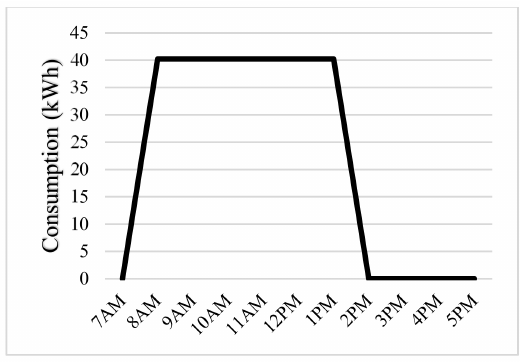
Figure 6. Hourly consumption in